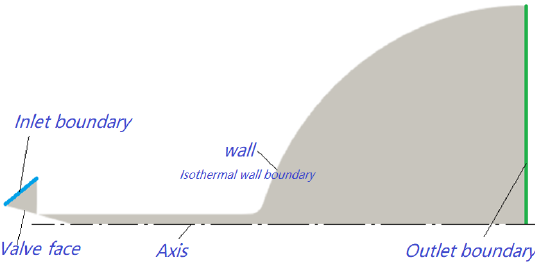
Figure 8. Computational domain.